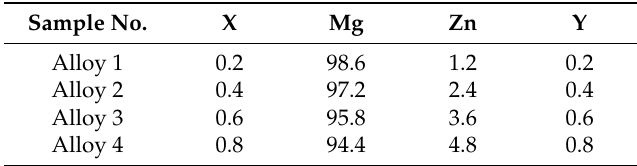
Table 1. The nominal compositions of Mg (100 − 7x) Zn 6x Y x alloys (at %). Sample